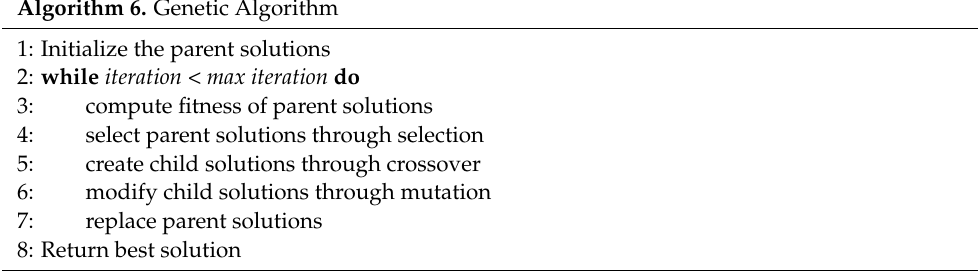
Algorithm 6. Genetic